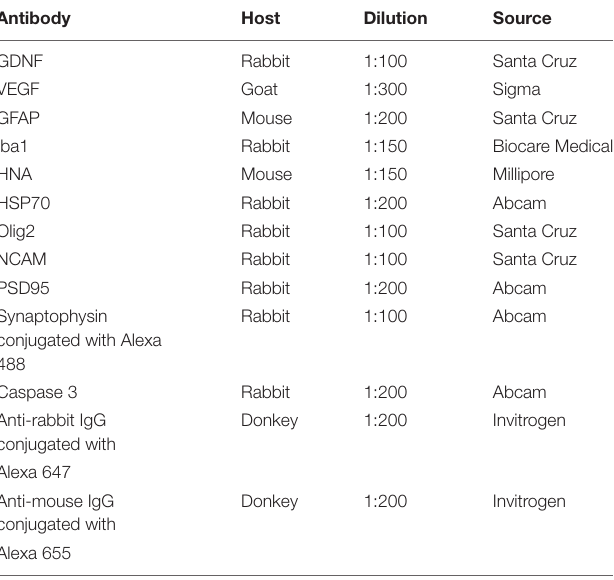
TABLE 1 | Primary and secondary antibodies used in immunofluorescent staining.